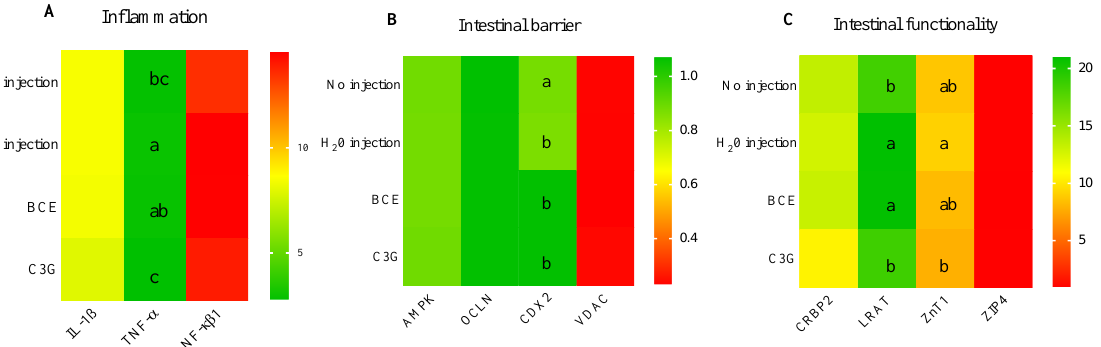
Figure 3. Effect of intra-amniotic administration of black corn extract on duodenal gene expression related to ( A ): intestinal inflammation biomarkers; ( B ): intestinal barrier biomarkers; ( C ): intestinal functionality biomarkers. Values are means (AU: arbitrary units) ± SED, n = 5 animals/group. BCE: black corn extract; C3G: cyanidin-3-glucoside. The treatment groups not indicated by the same letter are different ( p < 0.05) by the post-hoc Duncan test. Squares without any letters: no difference among the treatments ( p > 0.05). TNF α : tumor necrosis factor-alpha; NF- κβ 1: nuclear factor kappa beta -1; IL- 1β : interleukin 1 beta; AMPK: AMP-activated protein kinase; OCLN: occludin; CDX2: caudal-related homeobox transcriptional factor 2; VDAC: voltage-dependent anion channel; CRBP2: cellular retinol-binding protein-2; LRAT: lecithin retinol acyltransferase; ZnT1: Zinc transporter 1.